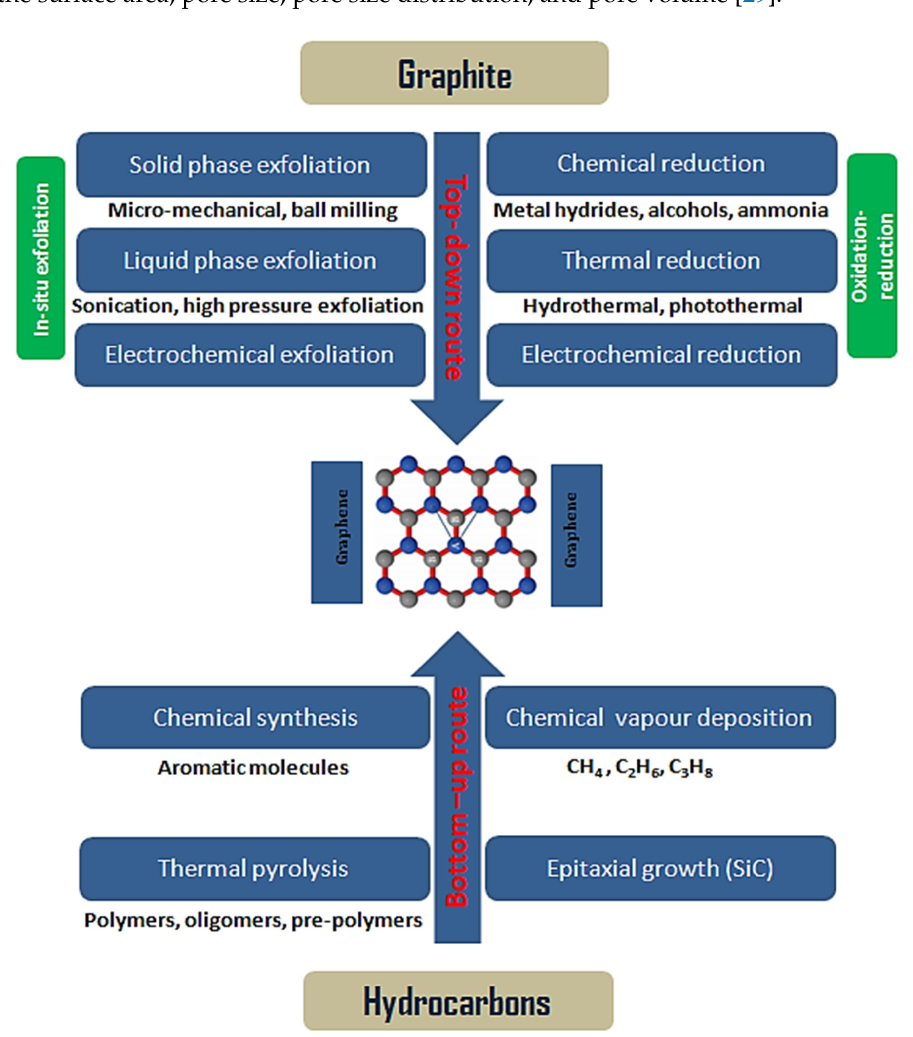
Figure 3. Schematic representation of most frequently used synthesis techniques of graphene.